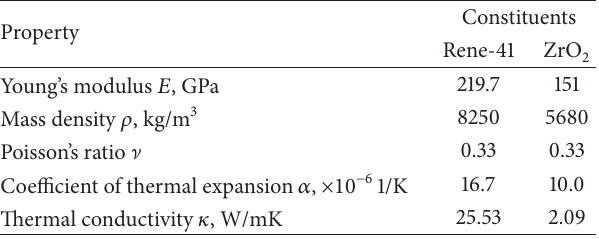
Constituents Rene-41 ZrO 2